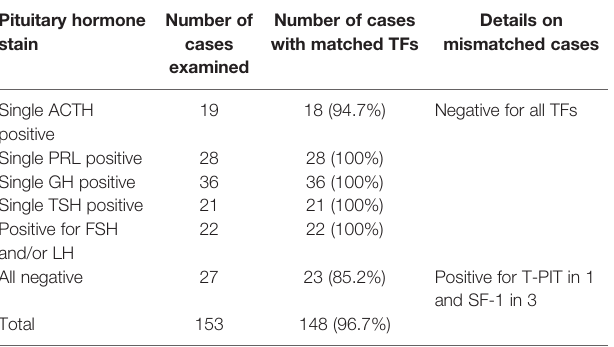
TABLE 2 | Retrospective comparison of immunohistochemistry between pituitary hormones and transcription factors. Pituitary hormone